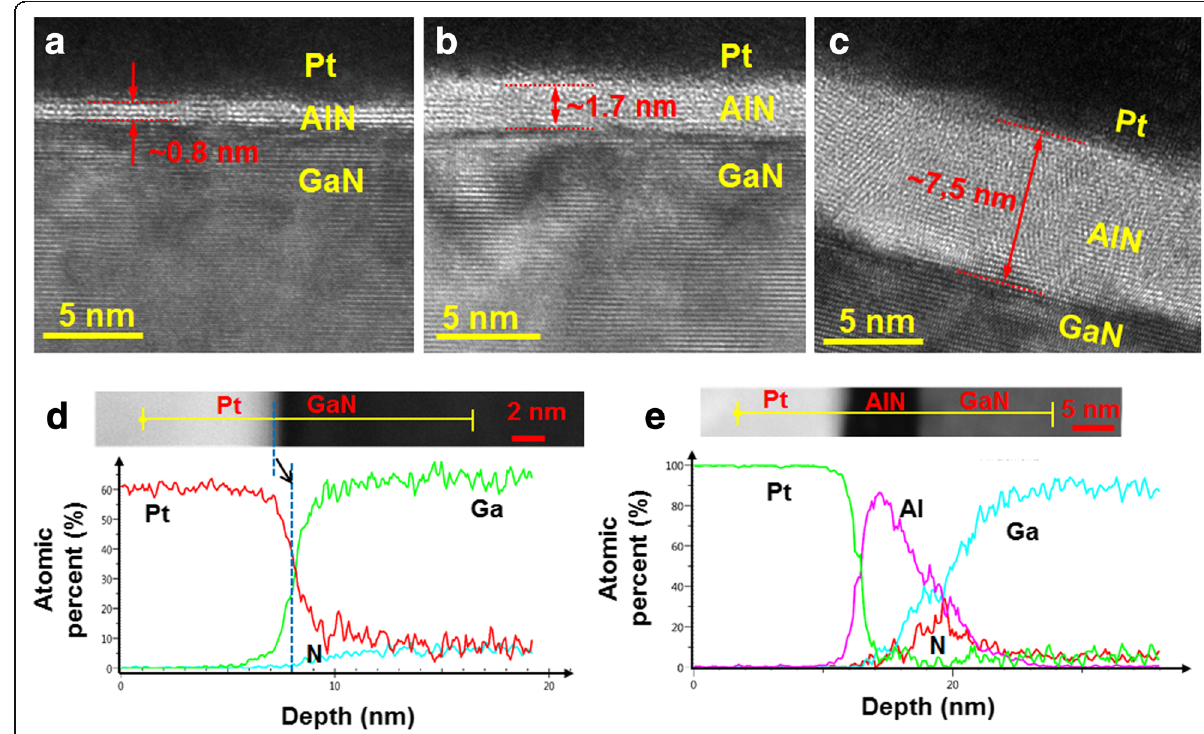
Fig. 1 Cross-sectional scanning transmission electron microscopy (STEM) images with a 0.7-, b 1.5-, and c 7.4-nm-thick AlN. d , e Atomic percent vs. depth profiles obtained from energy dispersive X-ray spectroscopy (EDS) line scans for the samples with 0- and 7.4-nm-thick AlN,